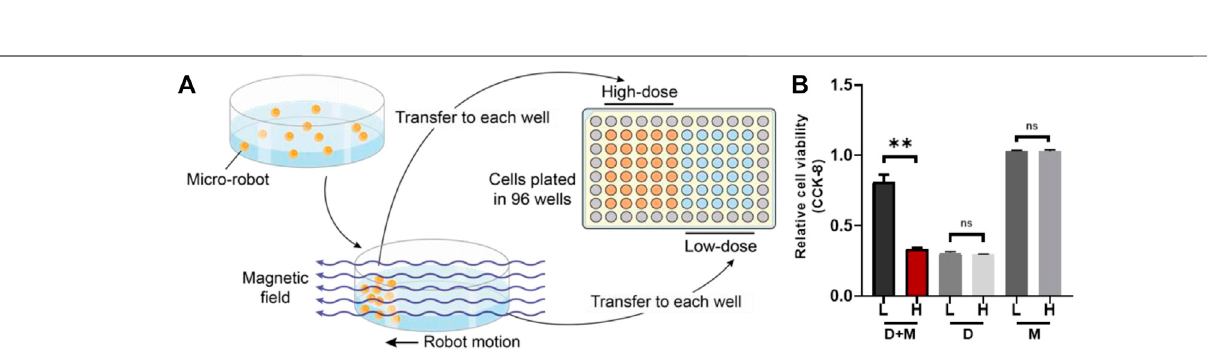
Frontiers in Bioengineering and Biotechnology |